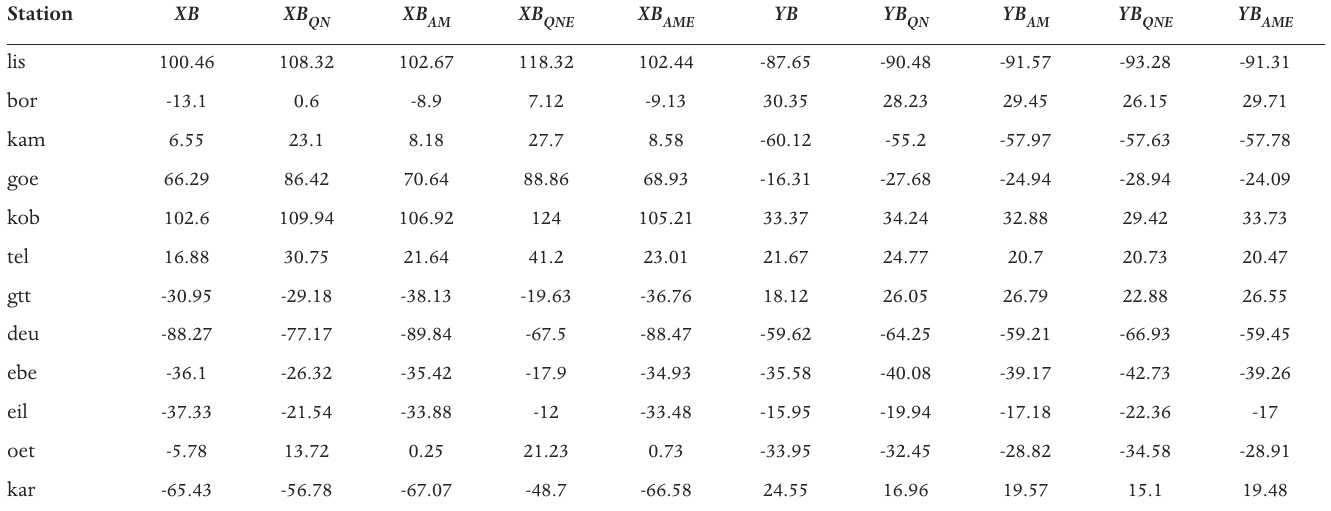
Table 3. Crustal bias estimates for X and Y component in